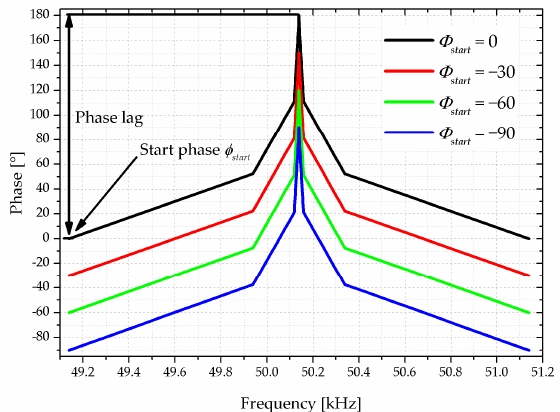
Figure 9. Phase characteristics of the stimulating voltage at the integrated piezoelectric layer with respect to the supply voltage of the shaker. The phase lag is kept constant while the starting phase φ start is varied to manipulate the Q-factor.